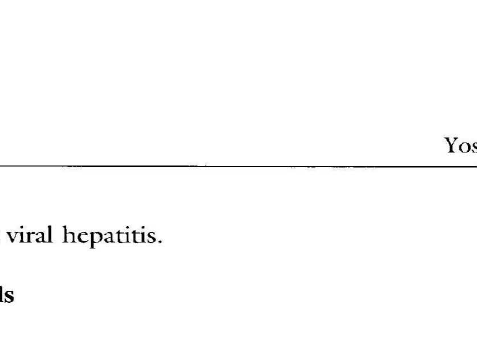
Table 2. Serum neopterin leyel in healthy subjects and patients with CLD Healthy subjects Patients with CLD FL AL CH-C CH-C with FL CH-C with AL CH-NBNC *Mean±SD.